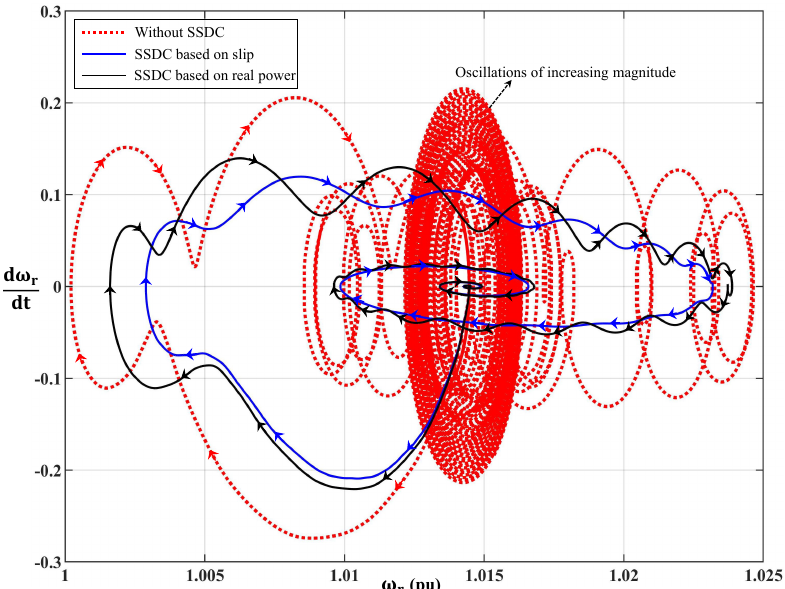
Figure 18. Phase plane trajectory of rotor speed in response to a grid frequency